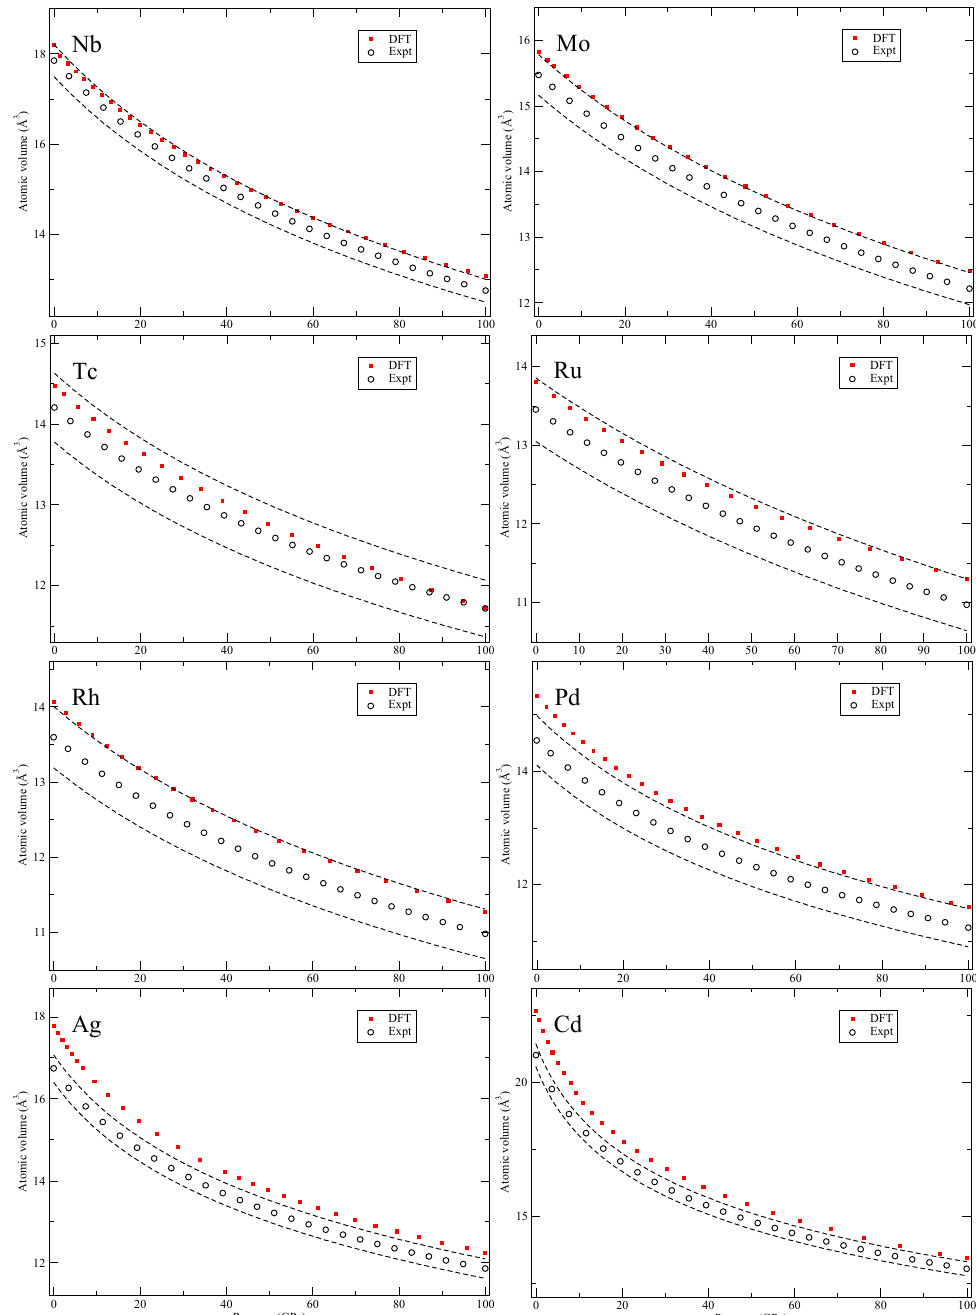
Figure 5. Experimental and DFT EOS for Nb, Mo, Tc, Ru, Rh, Pd, Ag and Cd.